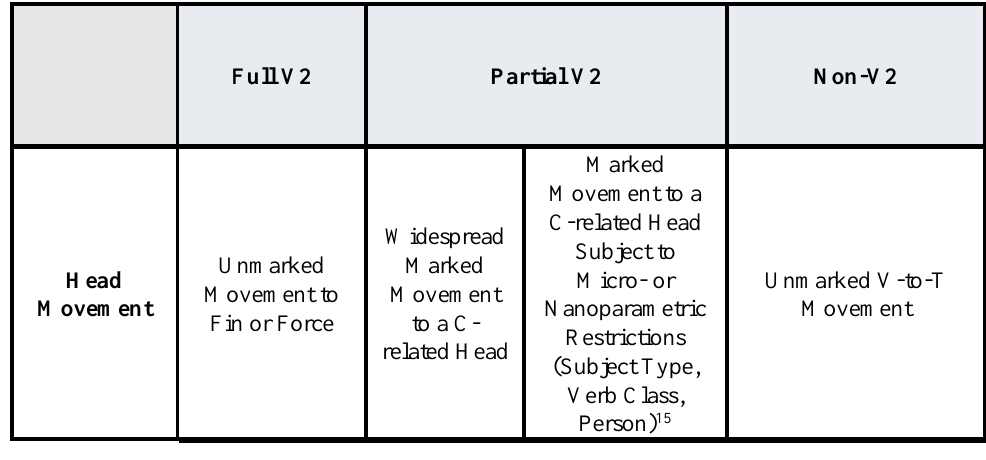
Table 4. Residual V2 as a Gradient Notion in